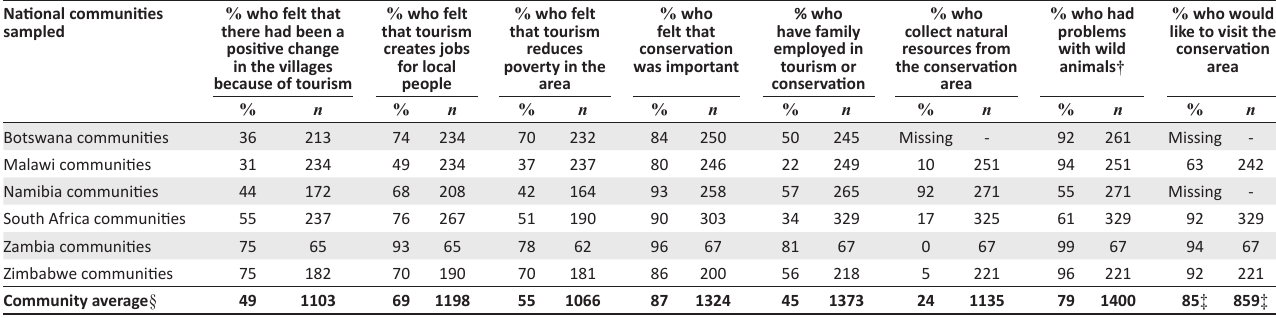
TABLE 3: Attitudes towards tourism and conservation by sampled communities. National communities sampled